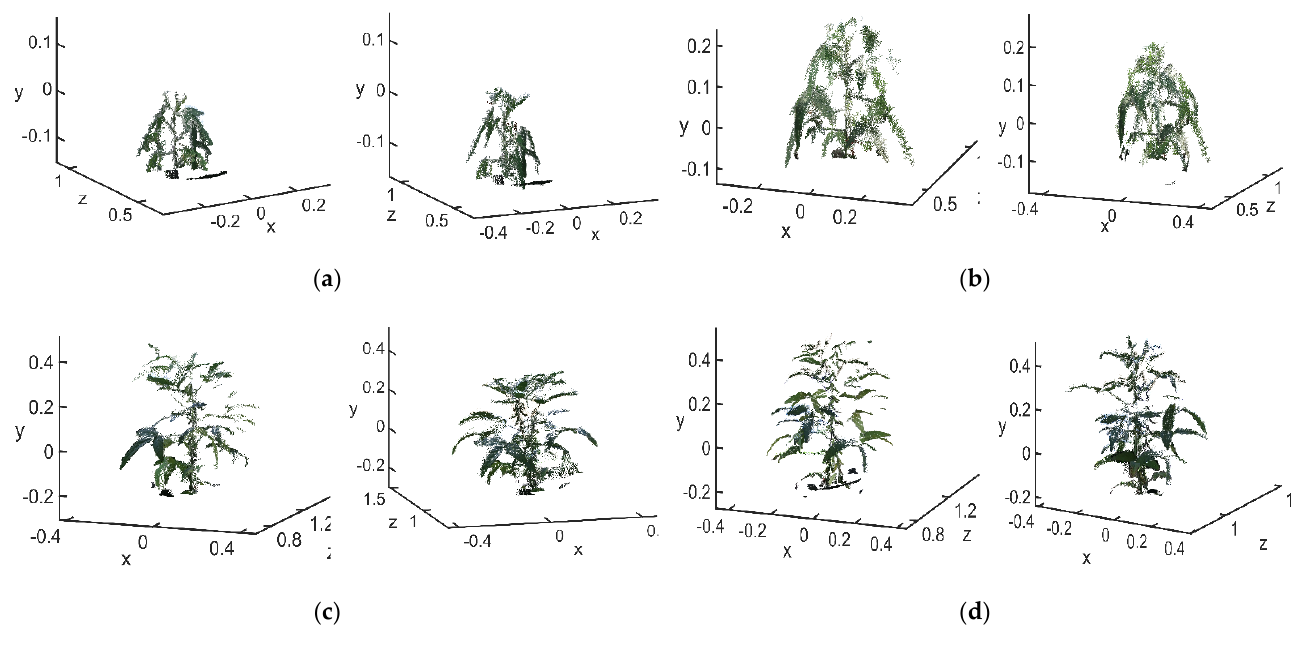
Figure 12. Rough registration results: (a) flowering stage; ( b ) podding stage; ( c ) filling stage; ( d ) mature stage.